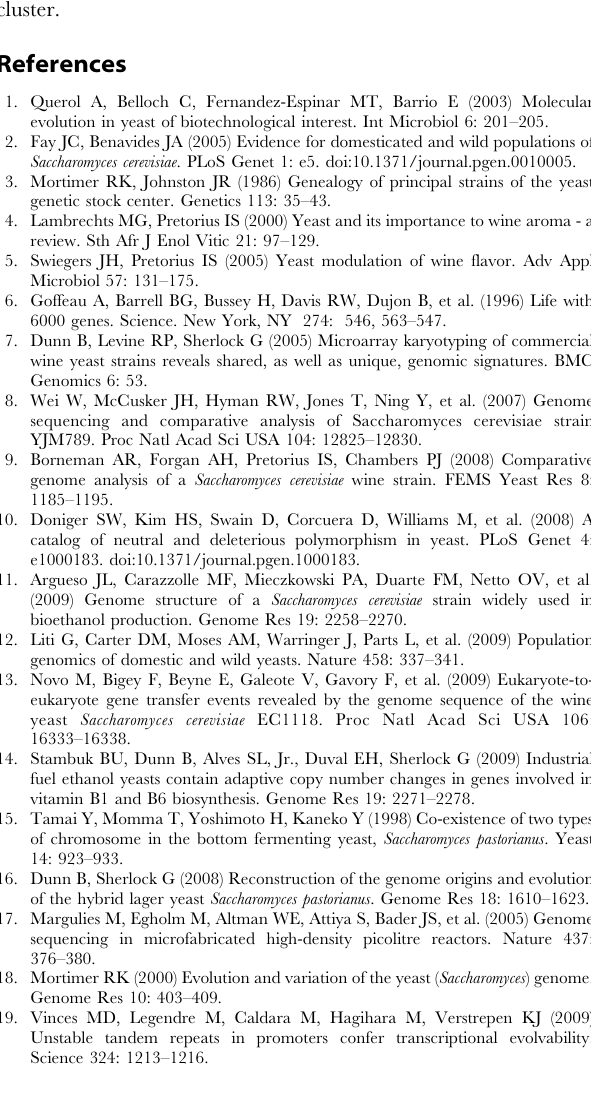
Figure S1 Clustal alignment of the hypothetical, conserved gene adjacent to RTM1 in the ale yeasts AWRI1684 and AWRI1685 and the human pathogen YJM789.